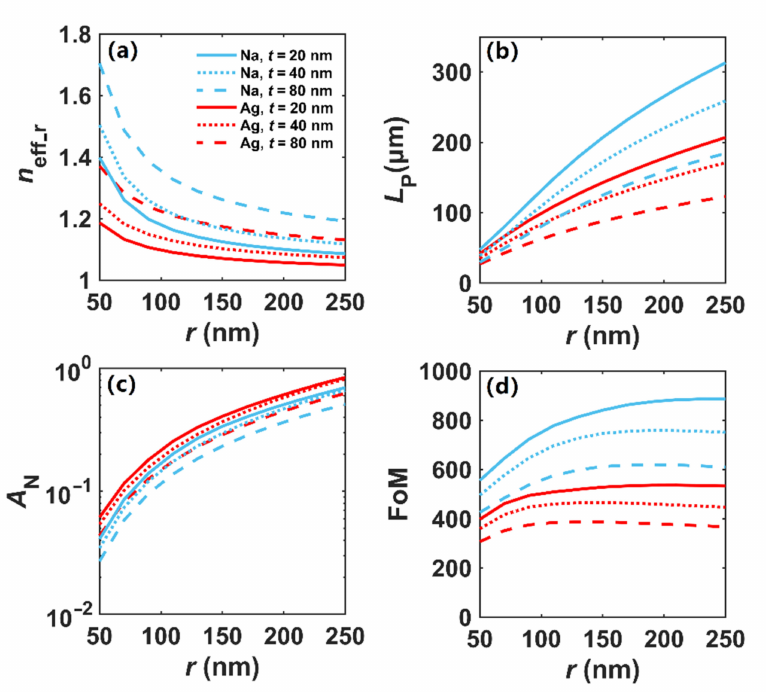
Figure 6. Modal properties of SiO 2 -coated Na and Ag nanowires with different radii. ( a ) n eff_r , ( b ) L P , ( c ) A N , ( d )